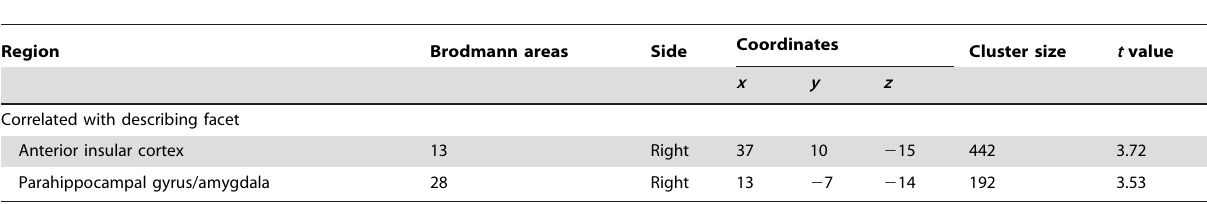
Table 1. Regions of gray matter positively correlated with each facet of mindfulness tendency.